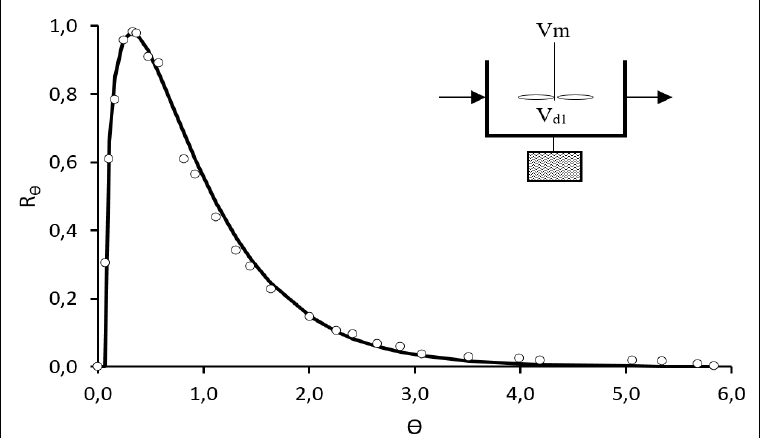
Figure 3: RTD curve for the stirred tank reactor with R 2 = 0.96, being (o) the experimental data and (-) the proposed